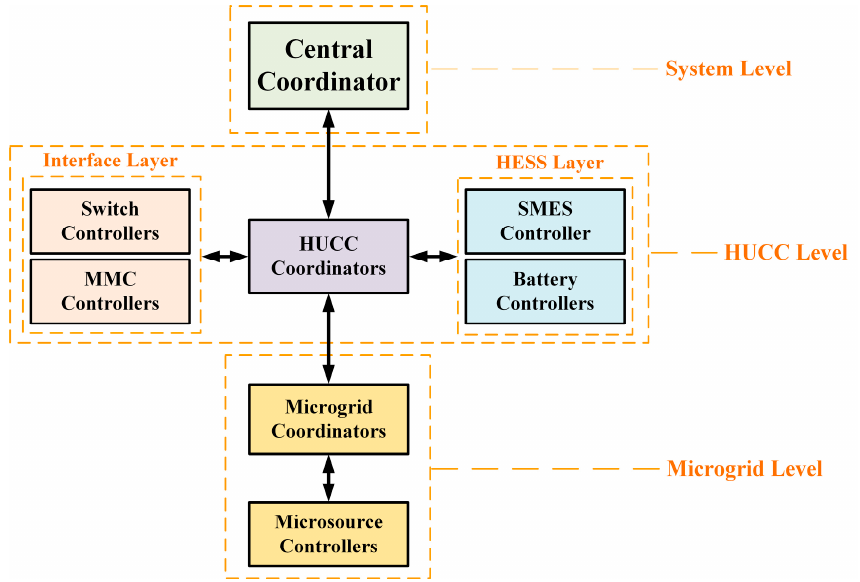
Figure 2. Multi-layer control architecture of the MMGs.